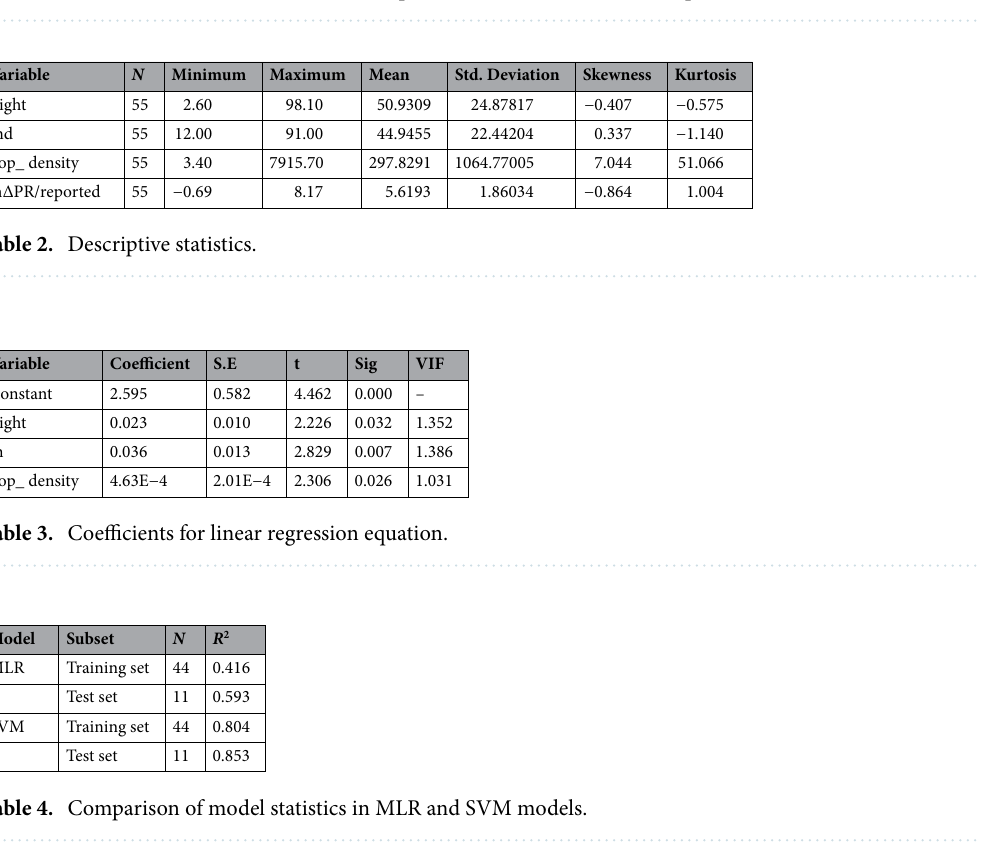
Table 1. Increased cases of novel coronavirus pneumonia in 55 countries and parameters used.